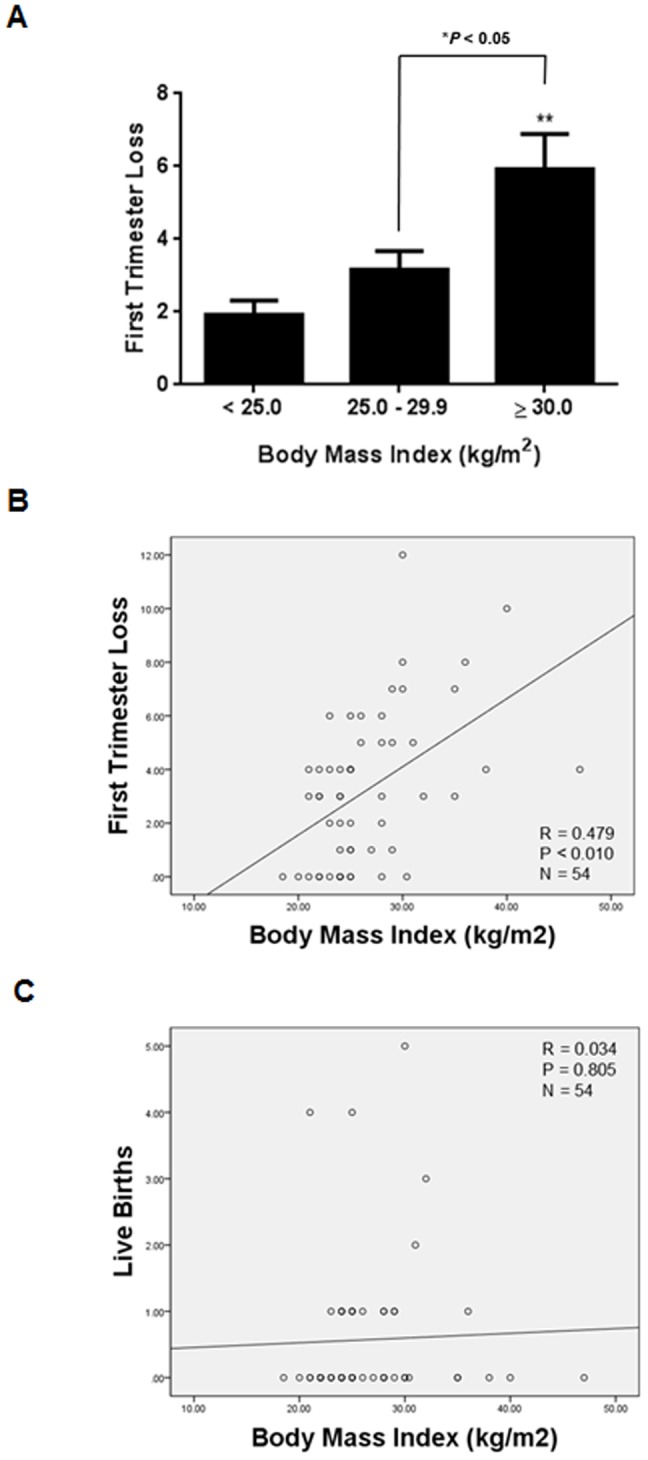
Body Mass Index and reproductive outcome.(A) First trimester pregnancy losses were significantly higher in obese subjects (n = 12) compared to overweight subjects (n = 20) and subjects with normal Body Mass Index (n = 22). First trimester losses in overweight subjects compared to subjects with normal Body Mass Index just failed to reach significance (P = 0.0565). Data are means ± SEM. Group comparison by ANOVA and post hoc Tukey’s test. *P<0.05, **P<0.01. (B) Relationship between first trimester pregnancy loss and Body Mass Index in all subjects. Pearson correlation coefficient: (R = 0.479, P<0.01). (C) Relationship between live births and Body Mass Index in all subjects. Pearson correlation coefficient: (R = 0.034, P = 0.805).